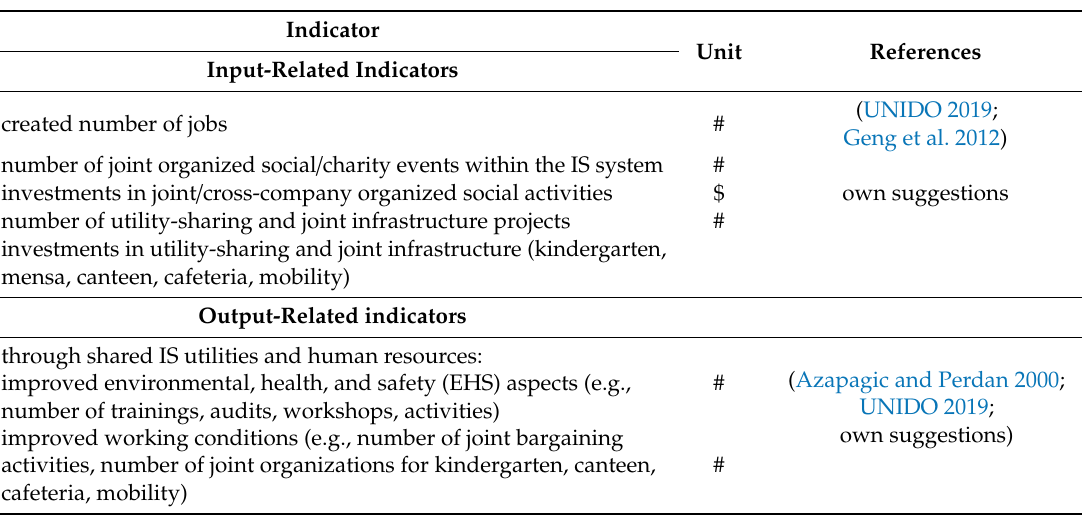
Table 6. IS social indicator